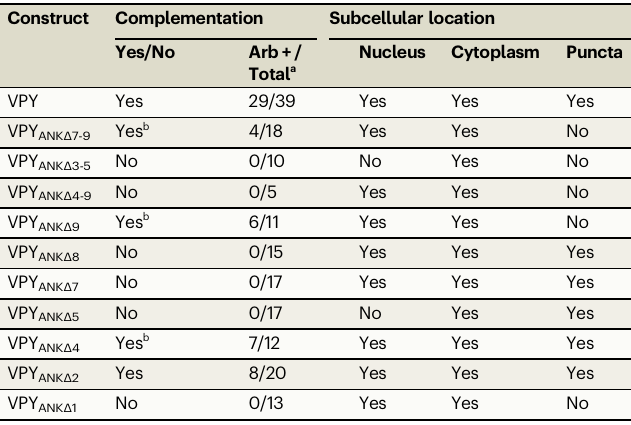
Table 1 | Functionality and subcellular location of VPY ankyrin deletion constructs Construct